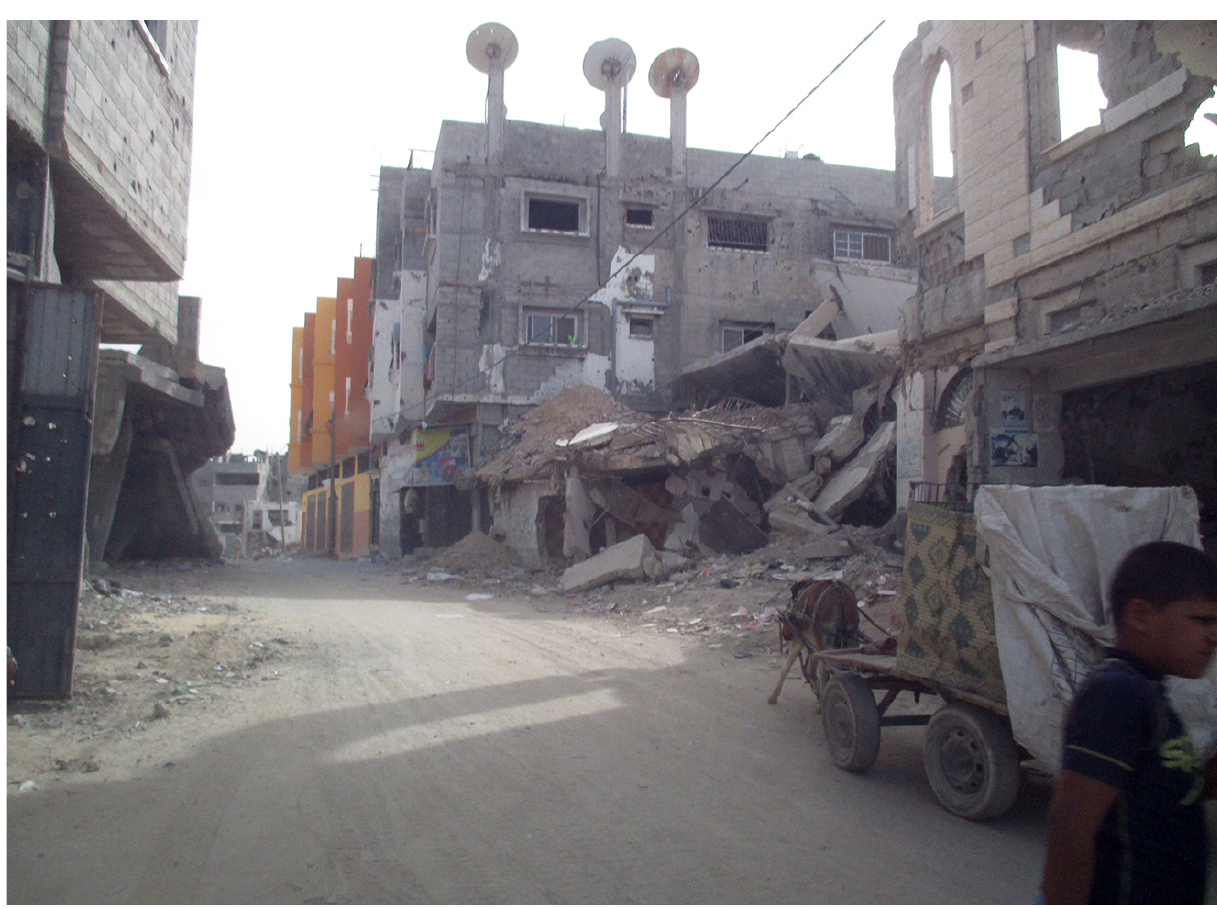
Figure 3. Demolition of housing suburbs in the Gaza